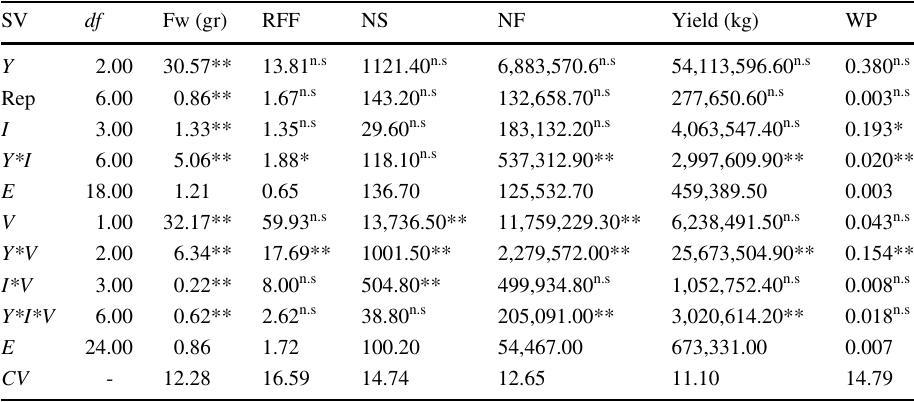
Table 8 Combined analysis of variance of quantitative features